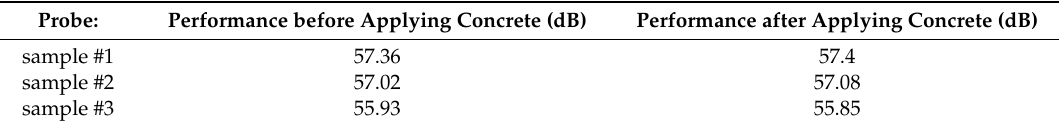
Table 1. Transmittance before and after applying concrete surrounding